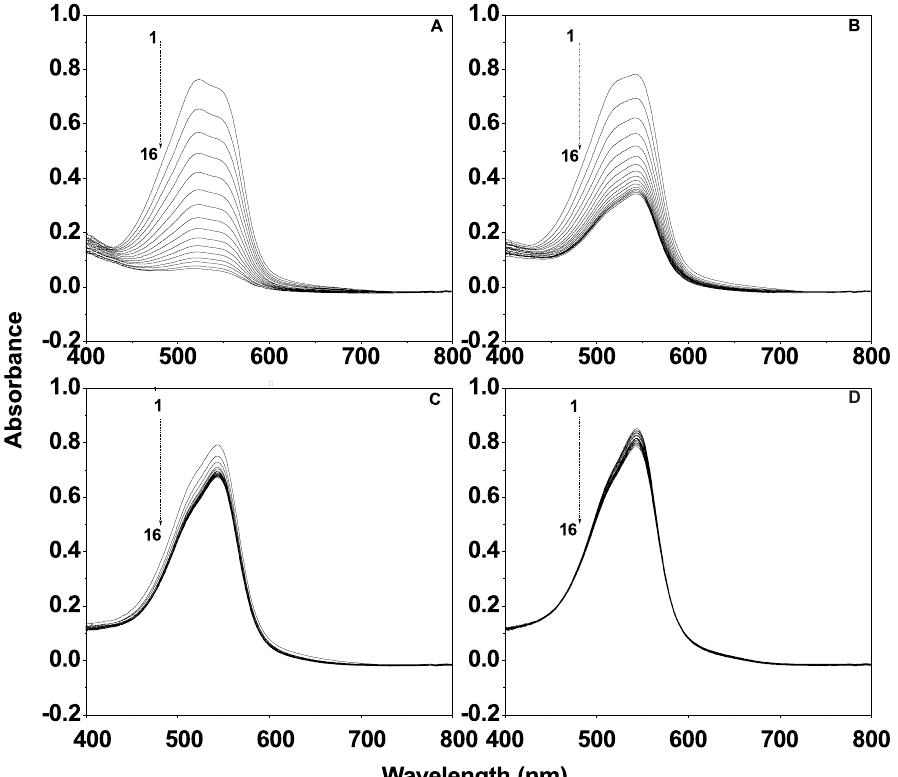
Figure 7. Spectral change of 0.050 mmol L -1 ACBK (A) and 0.050 mmol L -1 ACBK with 0.0100, 0.0200 and 0.0300 mmol L -1 Cu 2+ (B, C and D) at pH 5.0 buffer solutions with H O at different times. Spectra from 1 to 16 denote reacting times from 0 to 45 min with 3 min 2 2